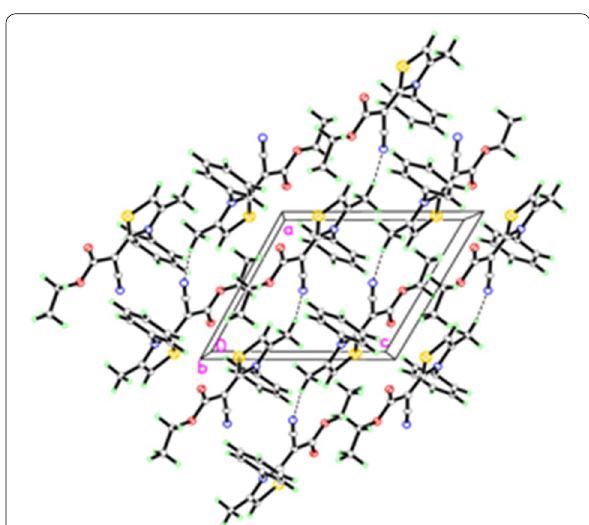
Fig. 2 Molecular packing of thiazole 6 viewed hydrogen bonds which are drawn as dashed lines along a